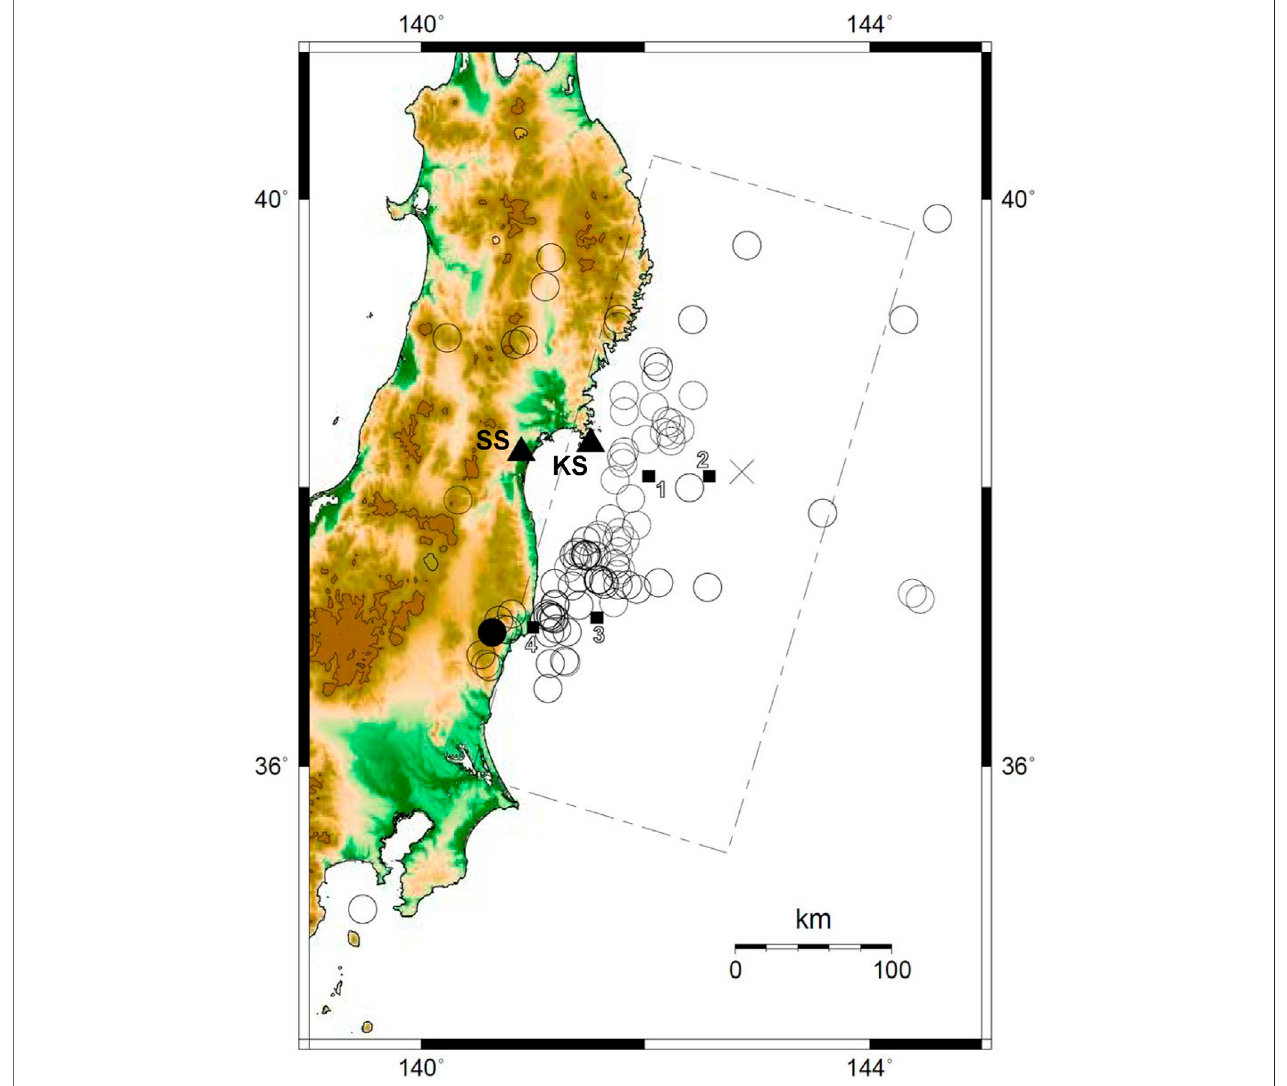
FIGURE 1 | Location of epicenters for moderate-sized earthquakes and seismic stations used in this study. Open circles show the location of epicenters for the moderate-sized earthquakes with a magnitude ( Mj ) of 5.0 – 6.0 for a period from November/2007 to August/2018 and, closed triangles show the location of seismic stations.Aclosed circleshowslocationofepicenterforanearthquake( Mj 5.9)occurredon11th/April2011.Theearthquakesourcefaultplaneofthe2011offthePaci fi c coastofTohokuearthquake( Mw 9.0)occurredon11th/March2011bySuzukietal.(2011)andthehypocenterbyJMAisalsoshownwithabrokenrectangleanda diagonalcross,respectively.Closedrectanglesshowlocationofepicentersforthestrongmotiongenerationareas(SMGAsof M 7-classevents)estimatedbyAsanoand Iwata (2012).